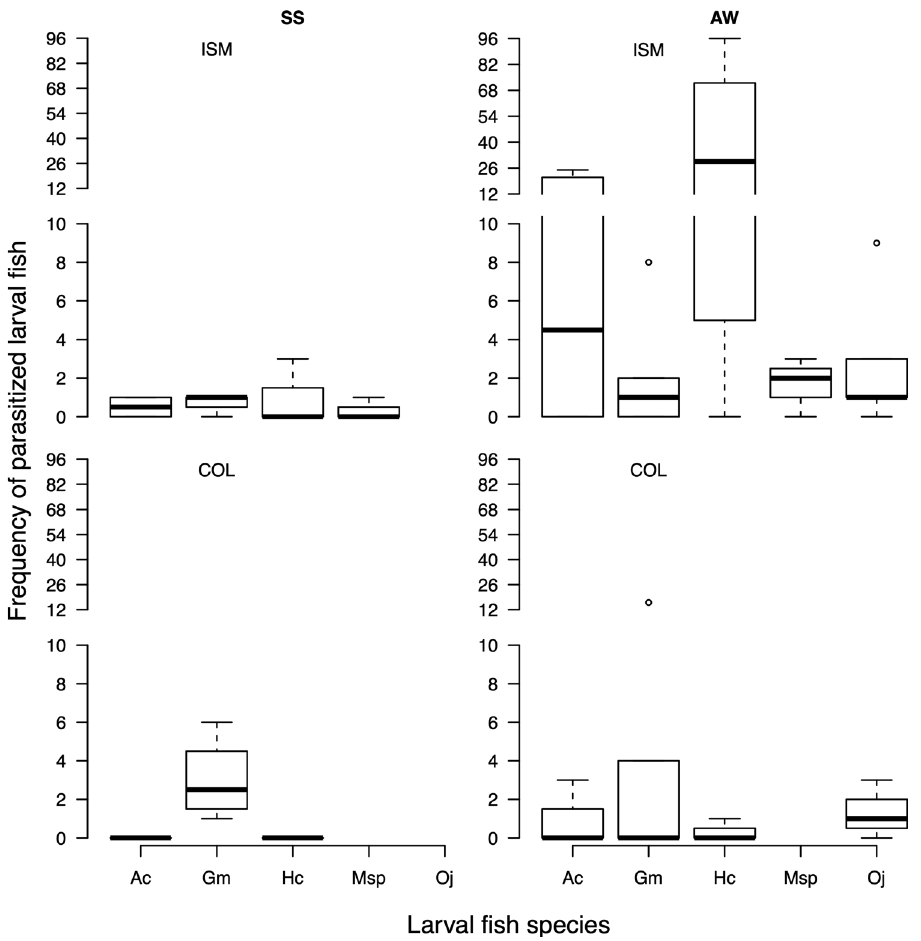
Figure 4. Boxplot of frequency of parasitized fish larvae observed in 5 fish species in two areas during the spring–summer and autumn–winter seasons. Bold line represents the median, inferior limit and superior box limit represent quantile 1 and 2 respectively, error bars represent maximum and minimum values. Ac, Auchenionchus crinitus ; Gm, Gobiesox marmoratus ; Hc, Helcogrammoides cunninghami , Msp, Myxodes sp.; Oj, Ophiogobius jenynsi